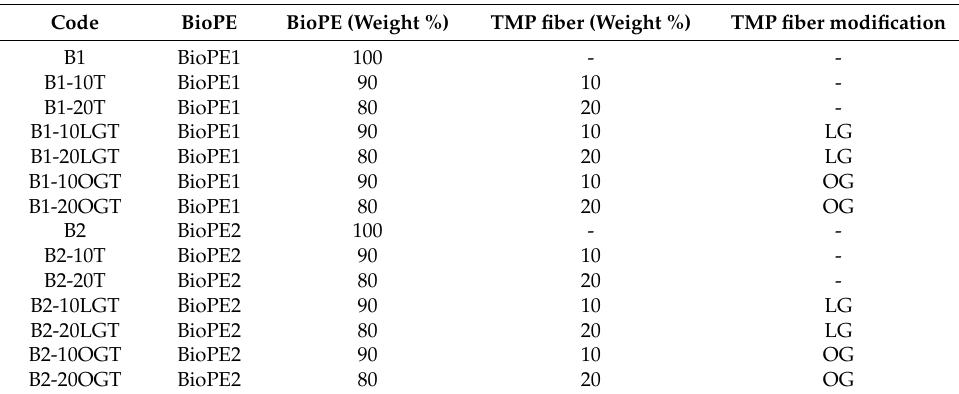
Table 1. Composition of biocomposite filaments for 3D